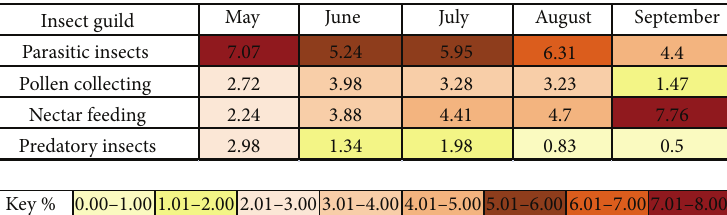
Figure 9: Heatmap-table summarising the relative abundance (%) of dominant guilds for each month, based on SIMPER analysis of count data recorded during the survey period.